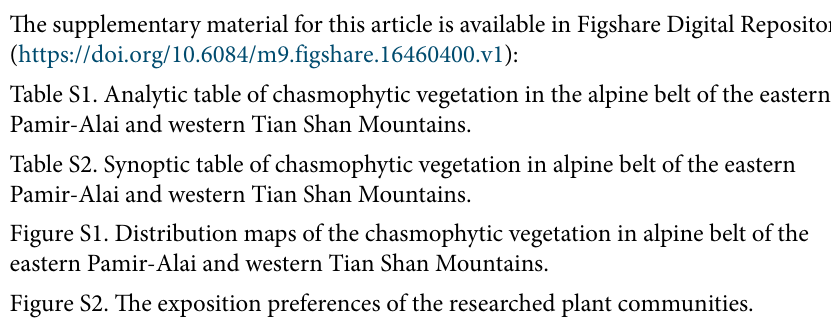
Table S2. Synoptic table of chasmophytic vegetation in alpine belt of the eastern Pamir-Alai and western Tian Shan Mountains. Figure S1. Distribution maps of the chasmophytic vegetation in alpine belt of the eastern Pamir-Alai and western Tian Shan Mountains. Figure S2. e exposition preferences of the researched plant